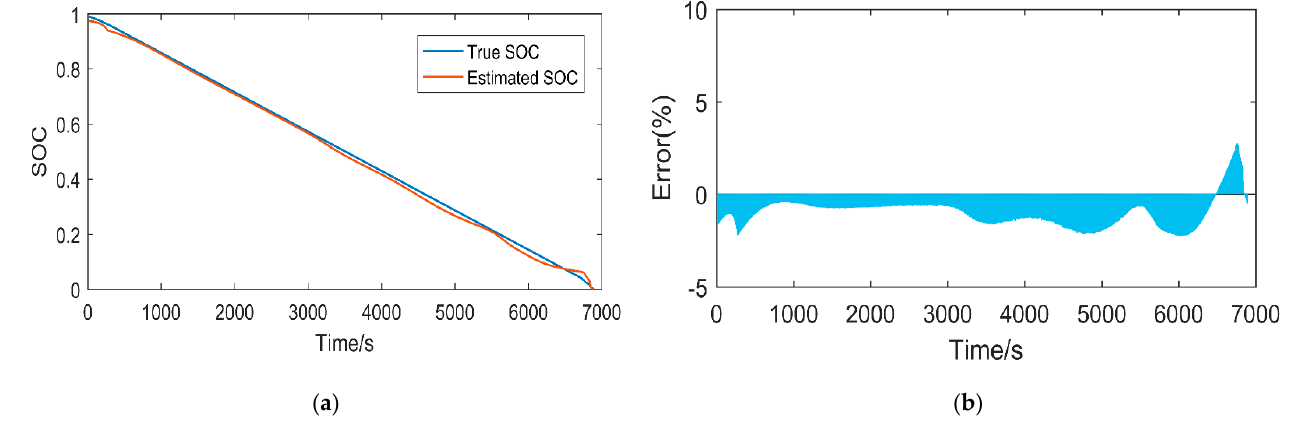
Figure 8. SOC estimation of the Bayes-BiLSTM model at 25 °C: estimated results ( a ) and estimated errors ( b ).